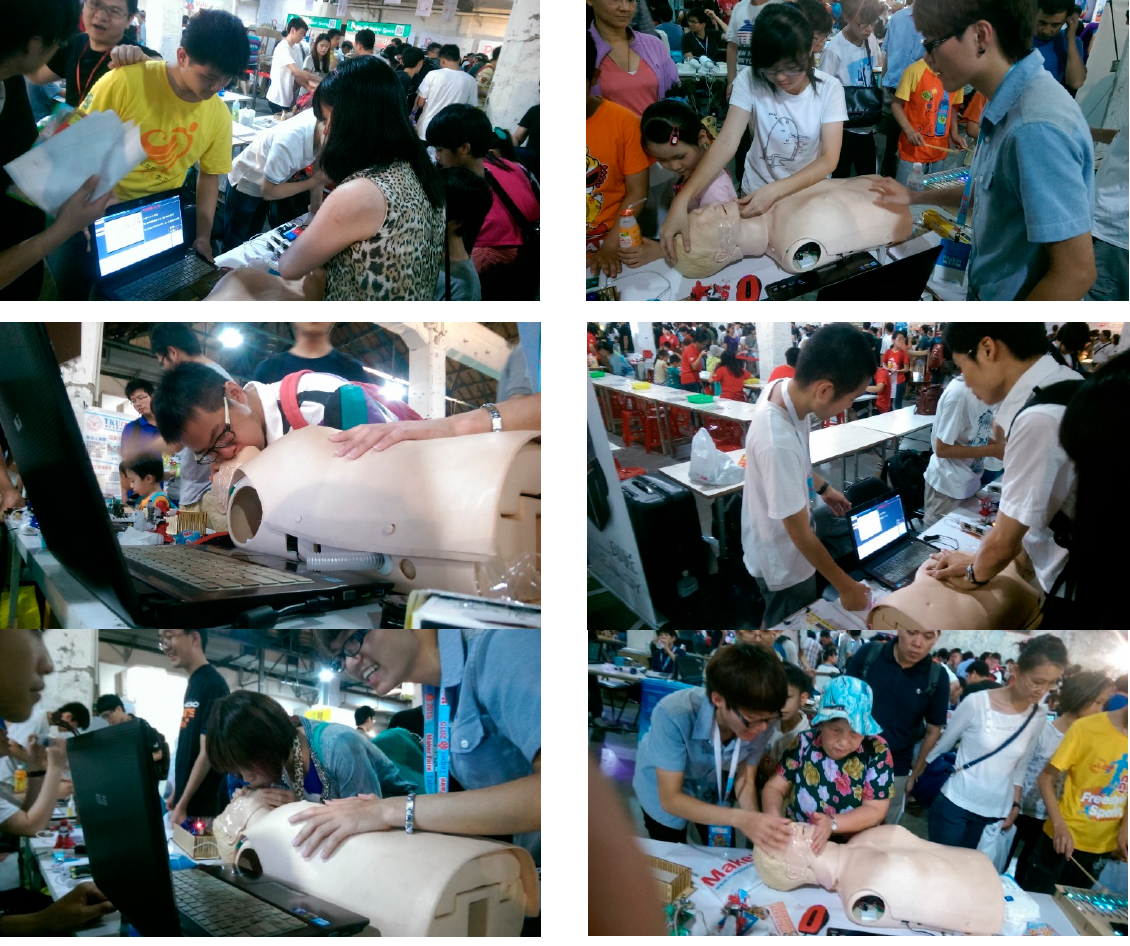
Figure 21. The example pictures of the public demonstration.